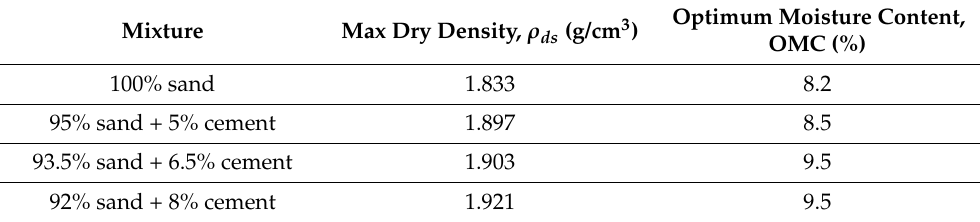
Table 2. Properties of the soil–cement mixtures.